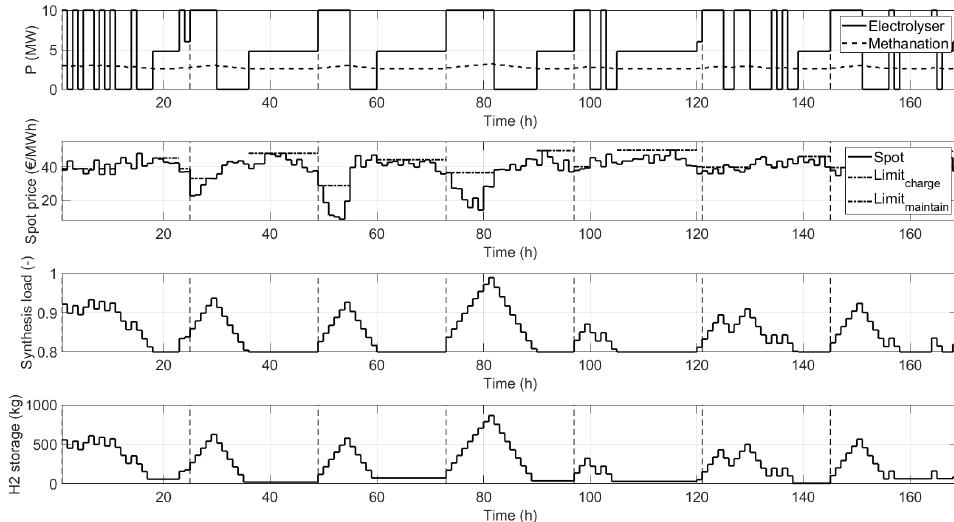
Figure 6. Optimization outcomes from methanol synthesis. Plots from top to bottom: power, spot price, synthesis load, and H 2